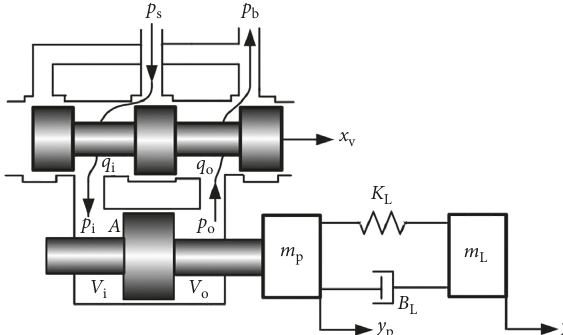
Figure 2: Schematic diagram of hydraulic power